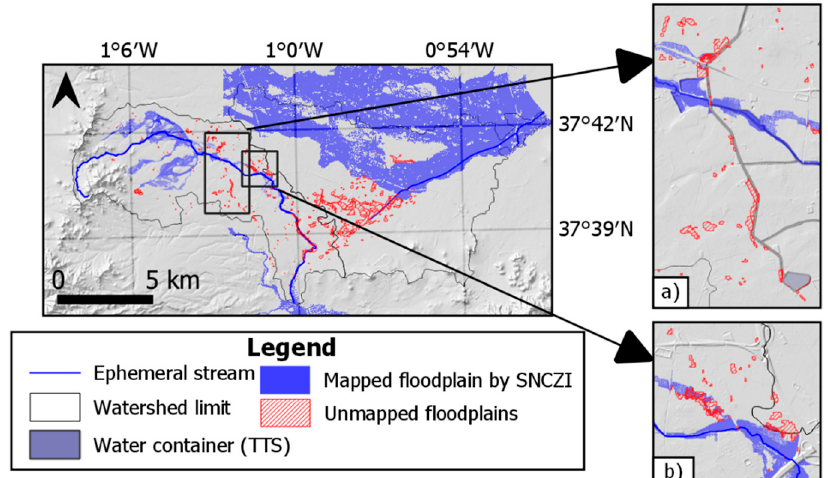
Figure 17. Flood-prone areas caused by human intervention: ( a ) shows floodable areas produced by terrain modifications made to mitigate the lack of fluvial connectivity caused by the Tagus-Segura Transfer (TTS) water channel; in the case of ( b ) irrigated crops under plastic produce a large extension of water during floods.